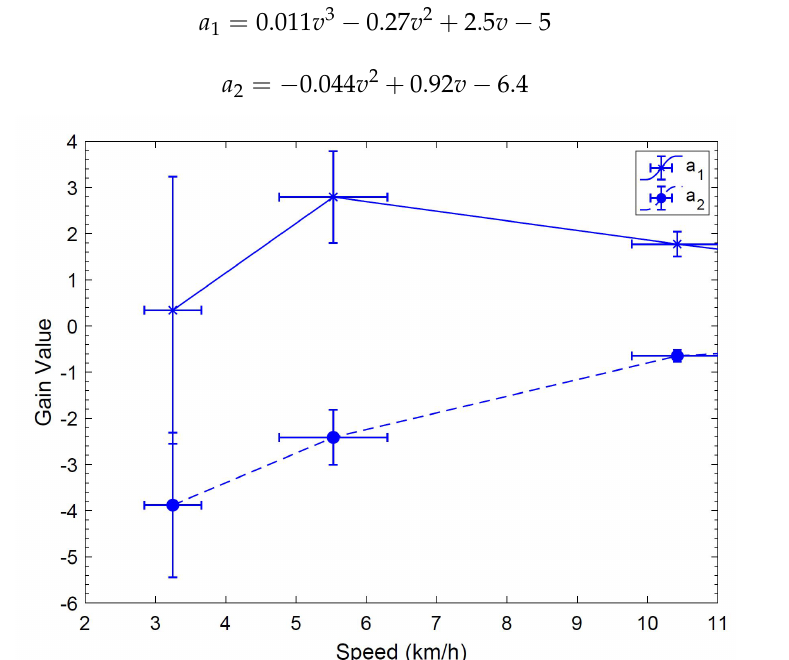
Figure 12. Regression coefficients for roll angle ( a 1 ) and roll rate ( a 2 ).